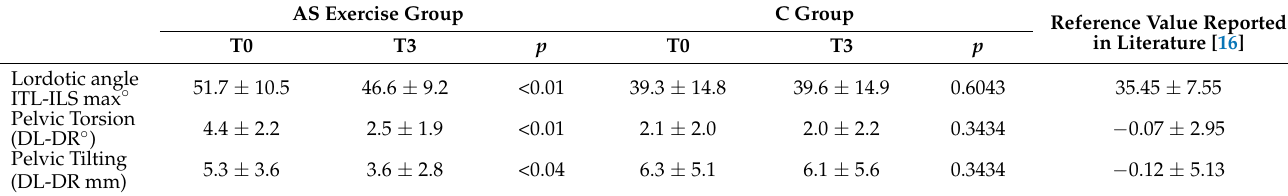
Table 3. Changes in postural parameters from the baseline (T0) to three months follow-up (T3). AS Exercise Group C